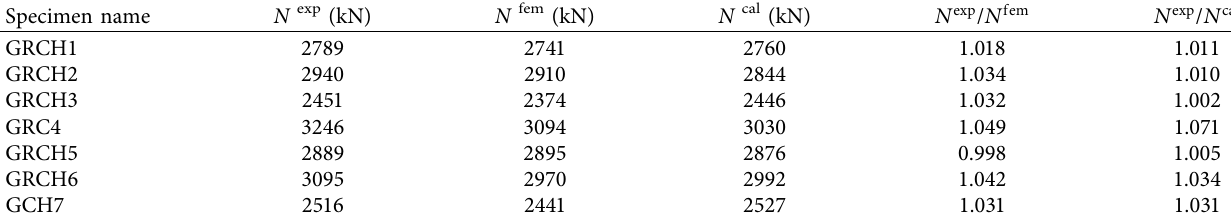
Figure 14: Te infuence of hollow ratio. Table 2: Experiment results and calculated results.